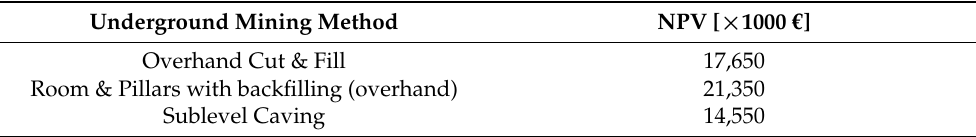
Table 1. NPV assessment for each one of the analyzed underground mining